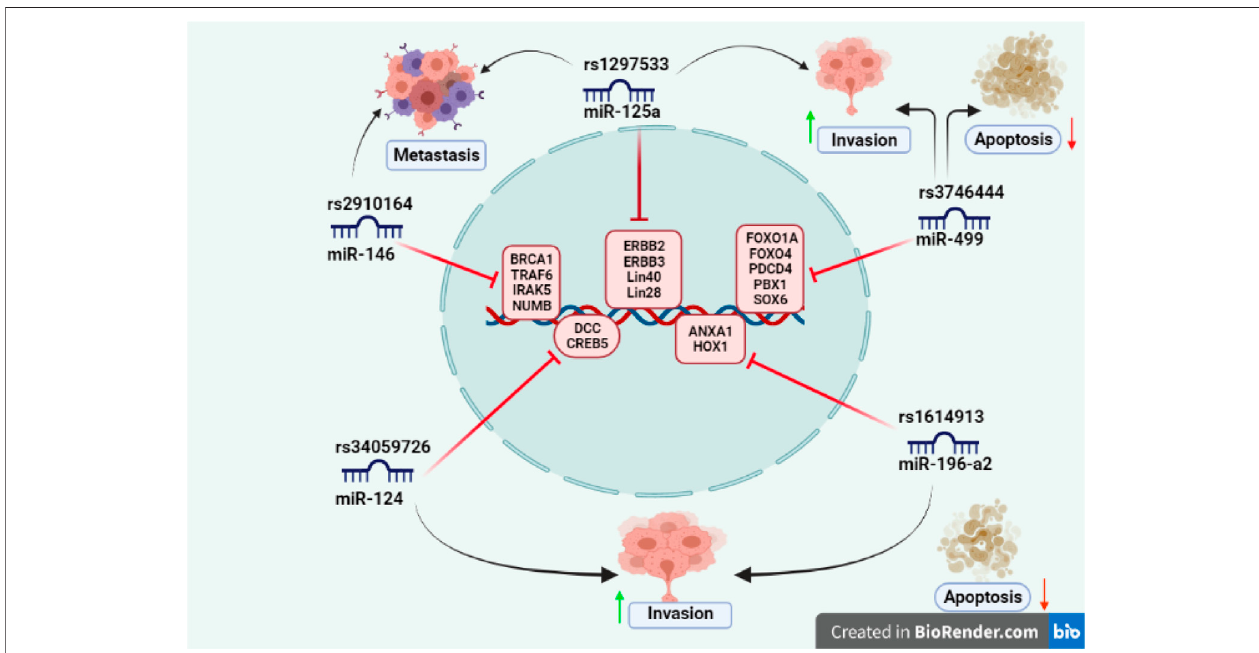
FIGURE 1 | SNPs reported in seed sequence of miRNA involved in cancer: miR-146 (rs2910164) targets include BRCA1, TRAF6, IRAKS, and NUMB gene and associatedwithcancermetastasis;miR-125a(rs1297533)foundtobeinvolvedininvasionandmetastasisandknowntargetsincludeERBB2,ERBB3,lin-40,andlin-28 gene; miR-499 (rs3746444) promotes invasion and inhibits cell apoptosis by targeting FOXO1A, FOXO4, PDCD4, PBX1, and SOX6 gene; miR-124 (rs34059726) has target genes DCC, CREB gene, and enhances invasion; miR-196-a2 (rs1614913) inhibits apoptosis and promotes invasion having target genes ANXA1 and HOX